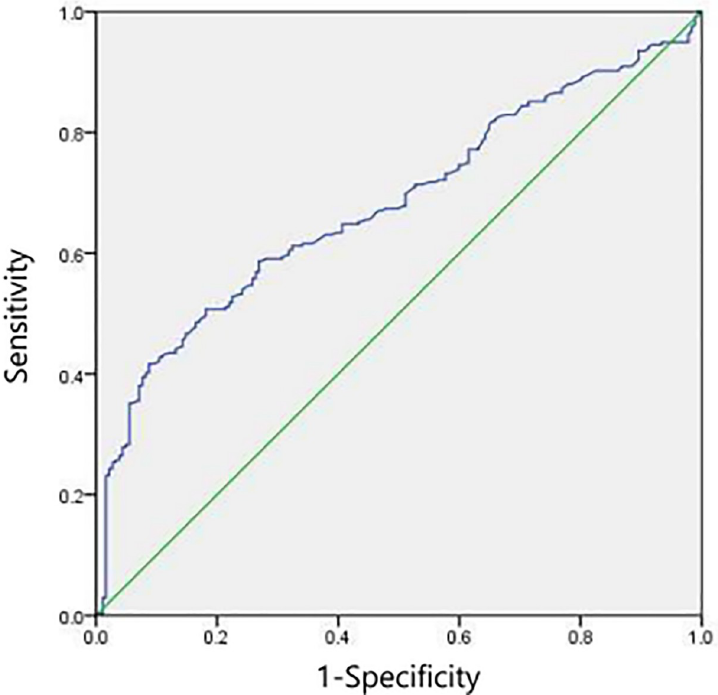
Fig 4. The best cut-off value for detecting developmental endothelial locus-1 (Del-1) protein according to the receiver operating characteristic curve. https://doi.org/10.1371/journal.pone.0250254.g004 (Sensitivity: 41.7%, Specificity: 90.7%) (Fig 4). PCa group had higher portion of patients with Del-1 protein � 0.120 than benign group (p < 0.001). Among the 182 patients diagnosed as benign, only 14 (7.7%) patients showed Del-1 protein 0.120 or higher. Fig 5 shows immunohistochemistry (IHC) results in benign prostate tissue and prostate adenocarcinoma according to pT stage and Gleason score. In IHC analysis using anti-Del-1 antibody (or anti-CD63 antibody), expression of Del-1 protein was higher in PCa tissue than in benign tissue. Furthermore, expression of Del-1 protein increased as the cancer stage and Gleason score increased.